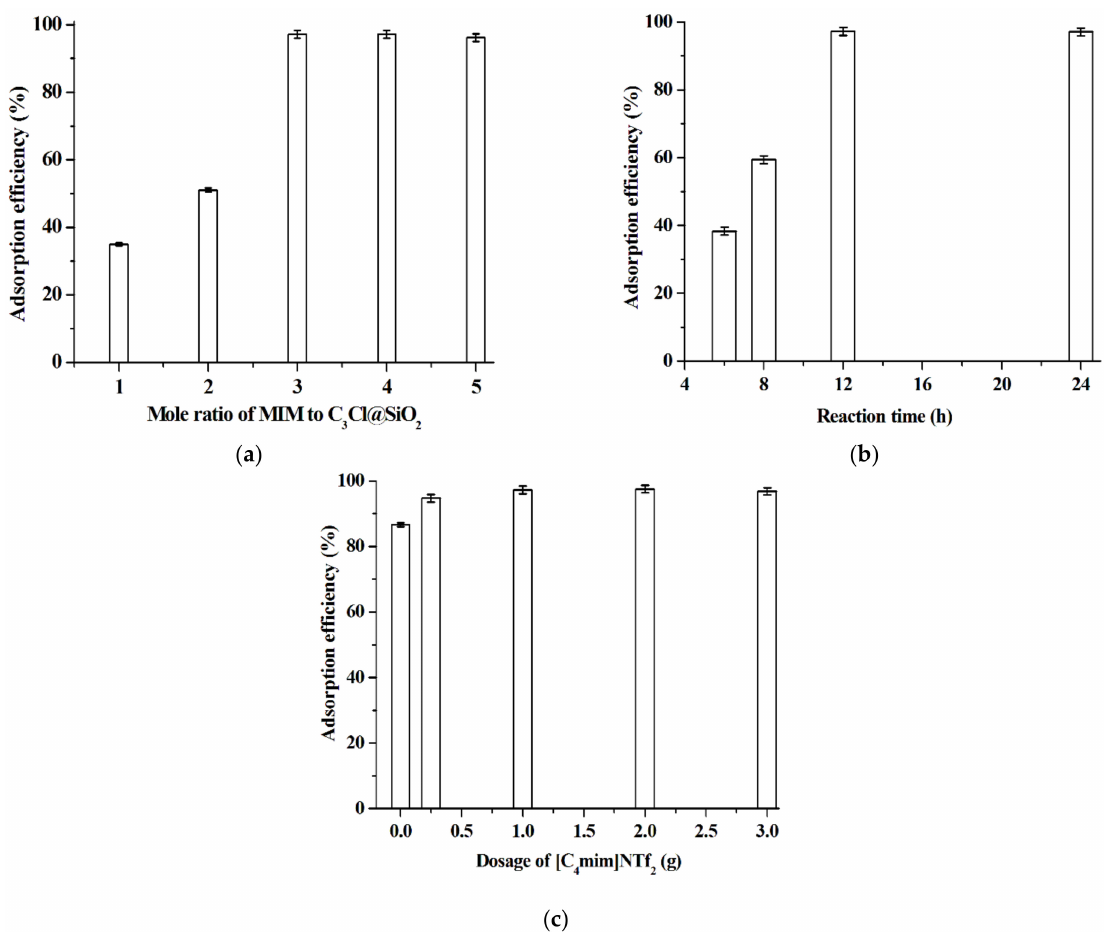
Figure 4. Effect of the mole ratio of MIM to C 3 Cl@SiO 2 ( a ) (dosage of [C 4 mim]NTf 2 , 1.0 g; mole ratio of CPTMOS to TEOS, 1.0; NH 3 concentration, 4.2 wt%; quaternization reaction time, 12 h; adsorption test: [C 3 mim] + Cl − @SiO 2 , 40 mg; baicalin aqueous solution, 5.0 × 10 − 5 mol · L − 1 , pH 5.0, 10 mL; adsorption time, 1 h; adsorption temperature, 25 ◦ C), reaction time of quaternization ( b ) (dosage of [C 4 mim]NTf 2 , 1.0 g; mole ratio of CPTMOS to TEOS, 1.0; NH 3 concentration, 4.2 wt%; mole ratio of MIM to C 3 Cl@SiO 2 of the quaternization reaction, 3.0; adsorption test: [C 3 mim] + Cl − @SiO 2 , 40 mg; baicalin aqueous solution, 5.0 × 10 − 5 mol L − 1 , pH 5.0, 10 mL; adsorption time, 1 h; adsorption temperature, 25 ◦ C) and dosage of [C 4 mim]NTf 2 ( c ) (mole ratio of CPTMOS to TEOS, 1.0; NH 3 concentration, 4.2 wt%; mole ratio of MIM to C 3 Cl@SiO 2 of the quaternization reaction, 3.0; quaternization reaction time, 12 h; adsorption test: [C 3 mim] + Cl − @SiO 2 , 40 mg; baicalin aqueous solution, 5.0 × 10 − 5 mol · L − 1 , pH 5.0, 10 mL; adsorption time, 1 h; adsorption temperature, 25 ◦ C) on the adsorption efficiency of [C 3 mim] + Cl − @SiO 2 . Experiments were conducted in